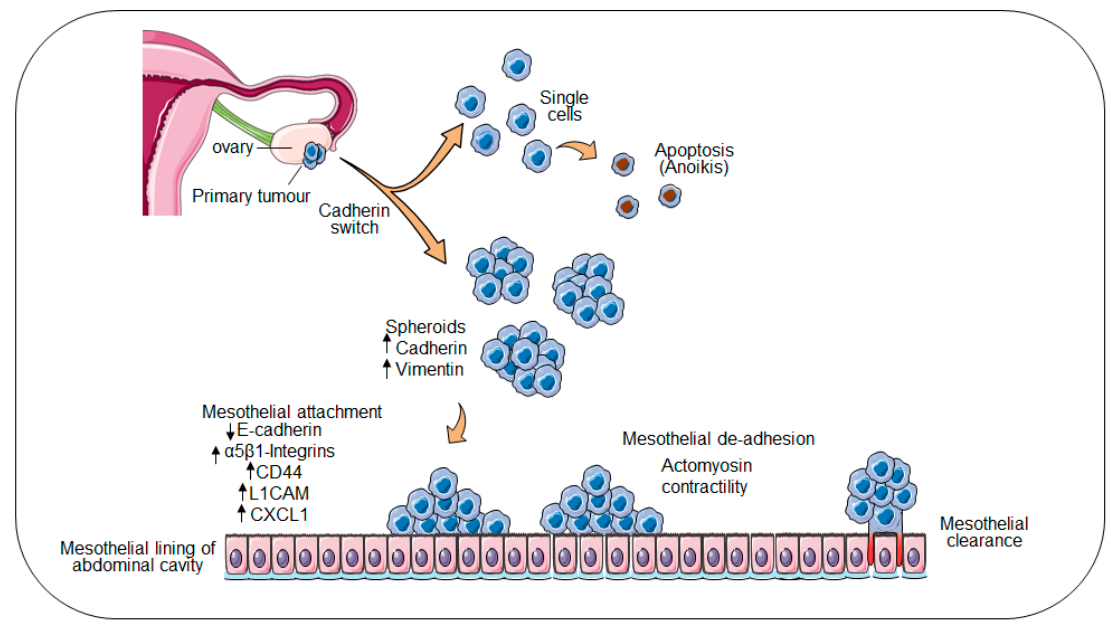
Figure 1. Metastasis model in ovarian cancer. A schematic model of ovarian cancer progression and dissemination. Ovarian cancer cells in the primary tumour acquire a unique expression profile and are exfoliated from the primary tumour site into the ascites. Ovarian cancer cells which have shed form multicellular aggregates are termed spheroids.erin. Spheres are carried passively within the peritoneum by the peritoneal fluid or ascites where they seed multiple distal metastasis by attaching to and clearing the mesothelial lining.